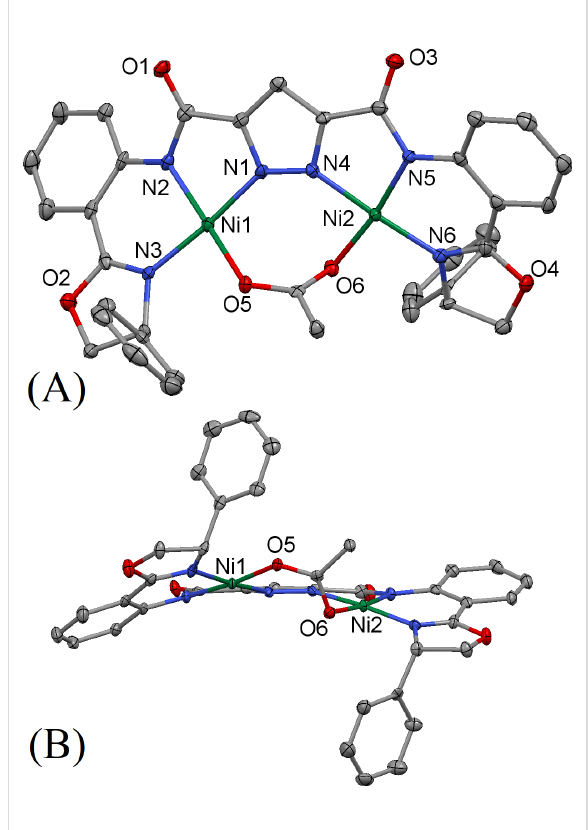
Figure 4: Thermal ellipsoid plot (50% probability) of the molecular structure of 25 ·Ni 2 (OAc). Hydrogen and solvate atoms have been omitted for clarity: (A) view normal to the mean molecular plane; (B) side view nearly perpendicular to (A) to allow better view of the region of open access to the metal site. The complex 25 ·Ni 2 (OAc) crystallizes in the monoclinic space group P 2 1 with a = 9.0473(9) Å, b = 17.5433(17) Å, c = 11.7671(11) Å, α = 90°, β = 109.643(2)°, γ = 90°, V = 1759.0(3) Å 3 , Z = 2, D c = 1.614 mg m − 3 and μ (Mo K α ) = 1.281 mm − 1